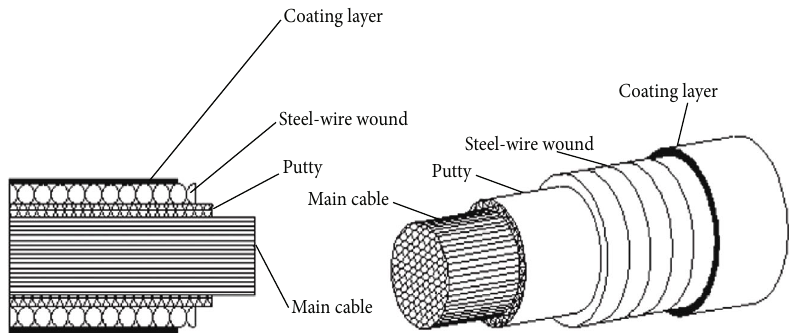
Figure 3: Schematic diagram of the Roebling